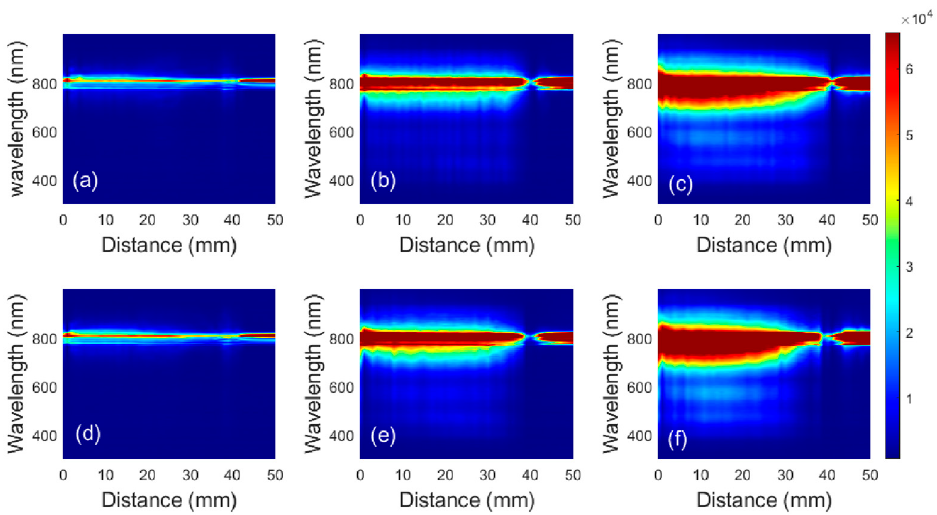
Figure 5. Variation of the SC induced by the filamentation of LG beams with D when the incident pulse energy is ( a , d ) 10, ( b , e ) 52 and ( c , f ) 104 μ J. ( a – c ) and ( d – f ) refers to the cases of l = 0 and l = 2.